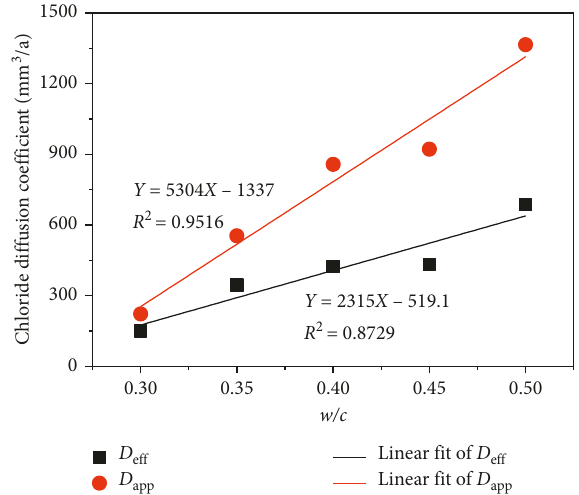
Figure 5: The relation between w / c and chloride diffusion coefficient.